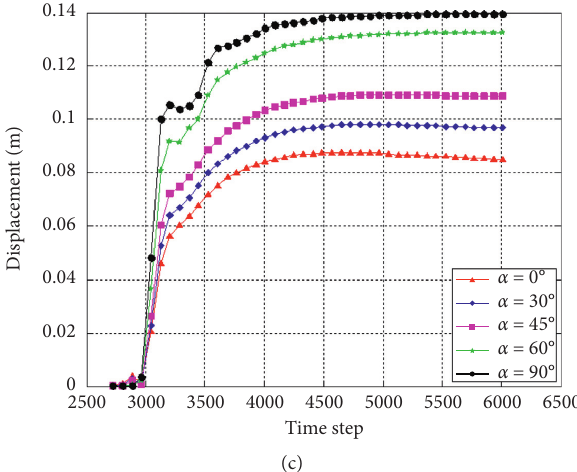
Figure 5: Simulation effect of tectonic stress direction on the tunnel. (a) Horizontal displacement of the left side. (b) Vertical displacement of the top side. (c) Vertical displacement of floor side.